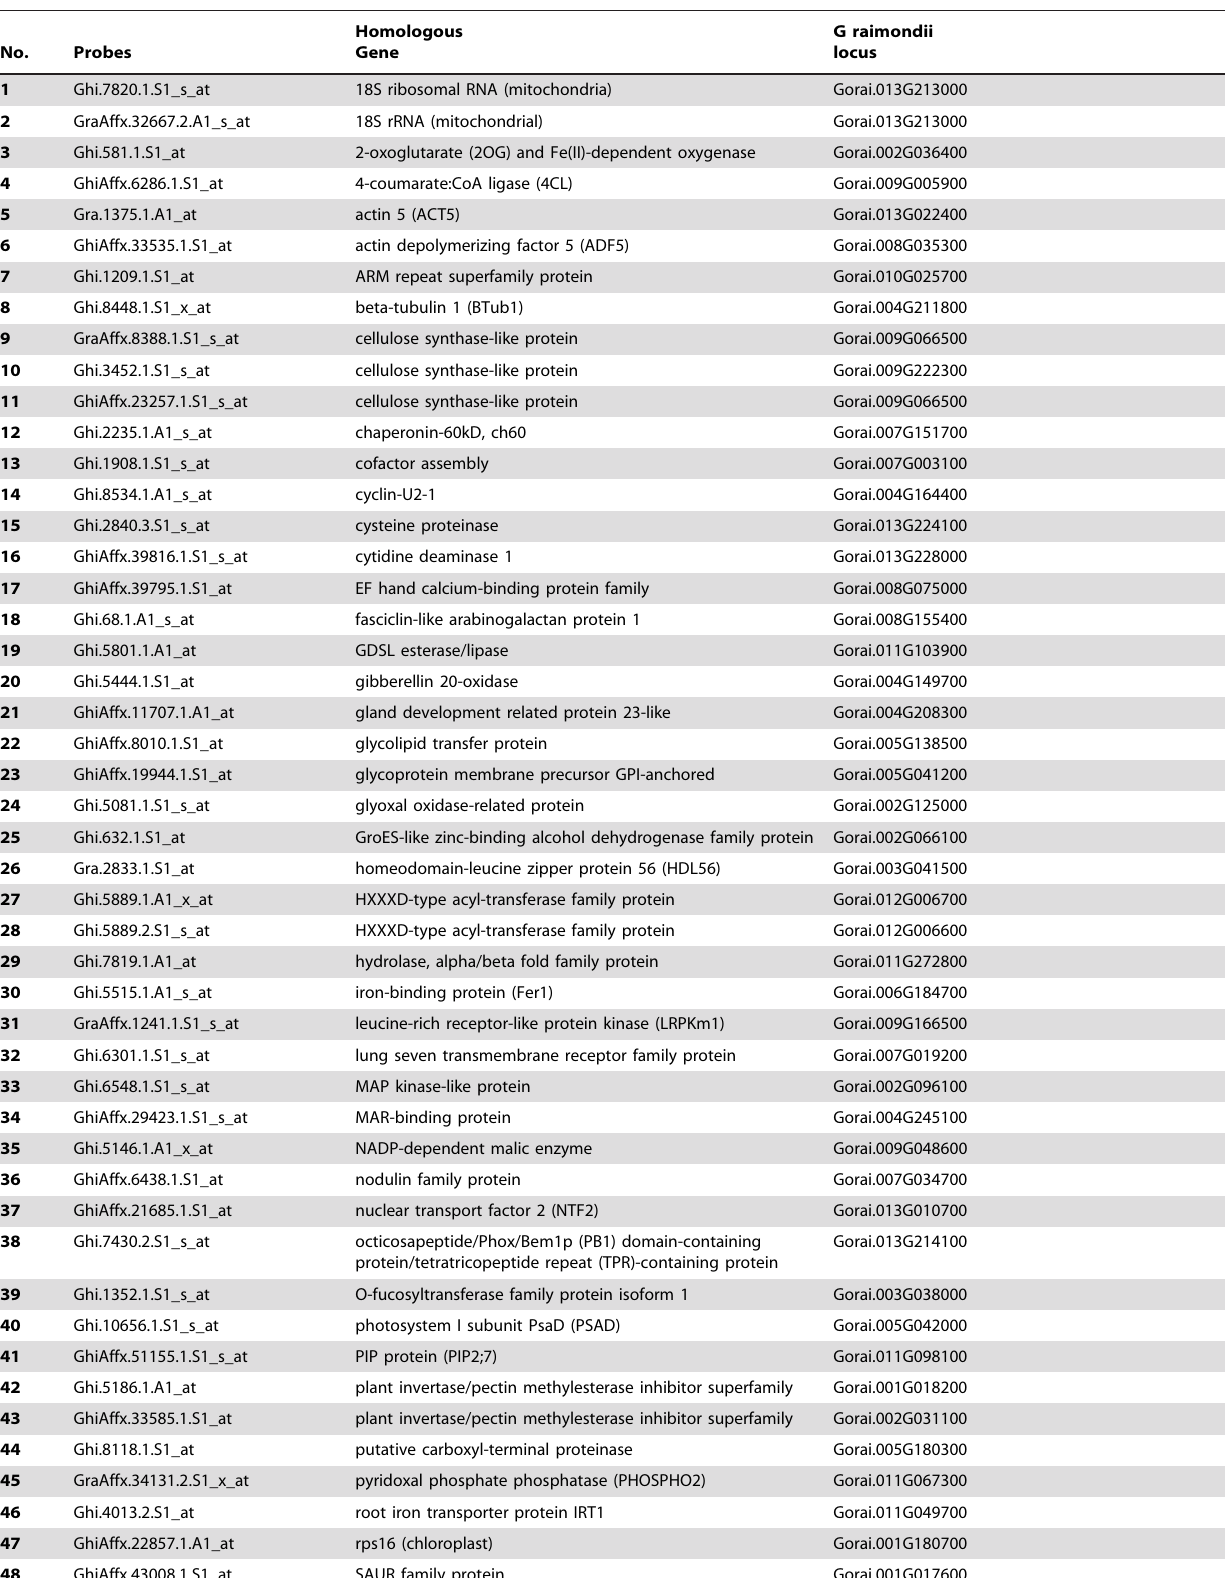
Table 1. Annotation of common DEGs identified from both Li 1 and Li 2 mutants regardless of growth conditions.